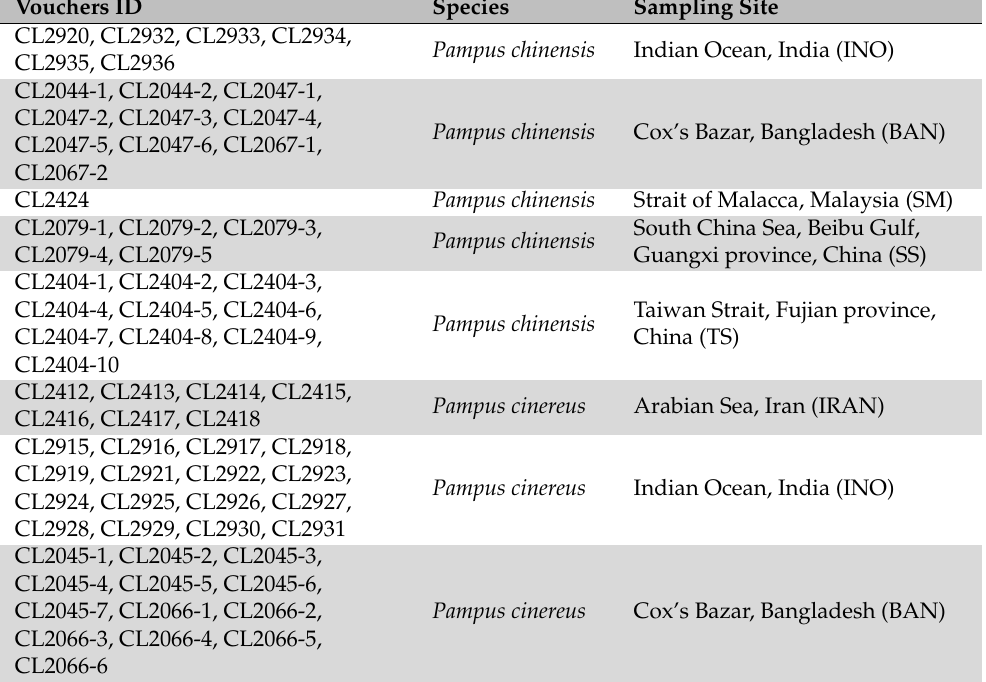
Table 1. Ninety-nine Pampus individuals and two outgroup taxa used in this